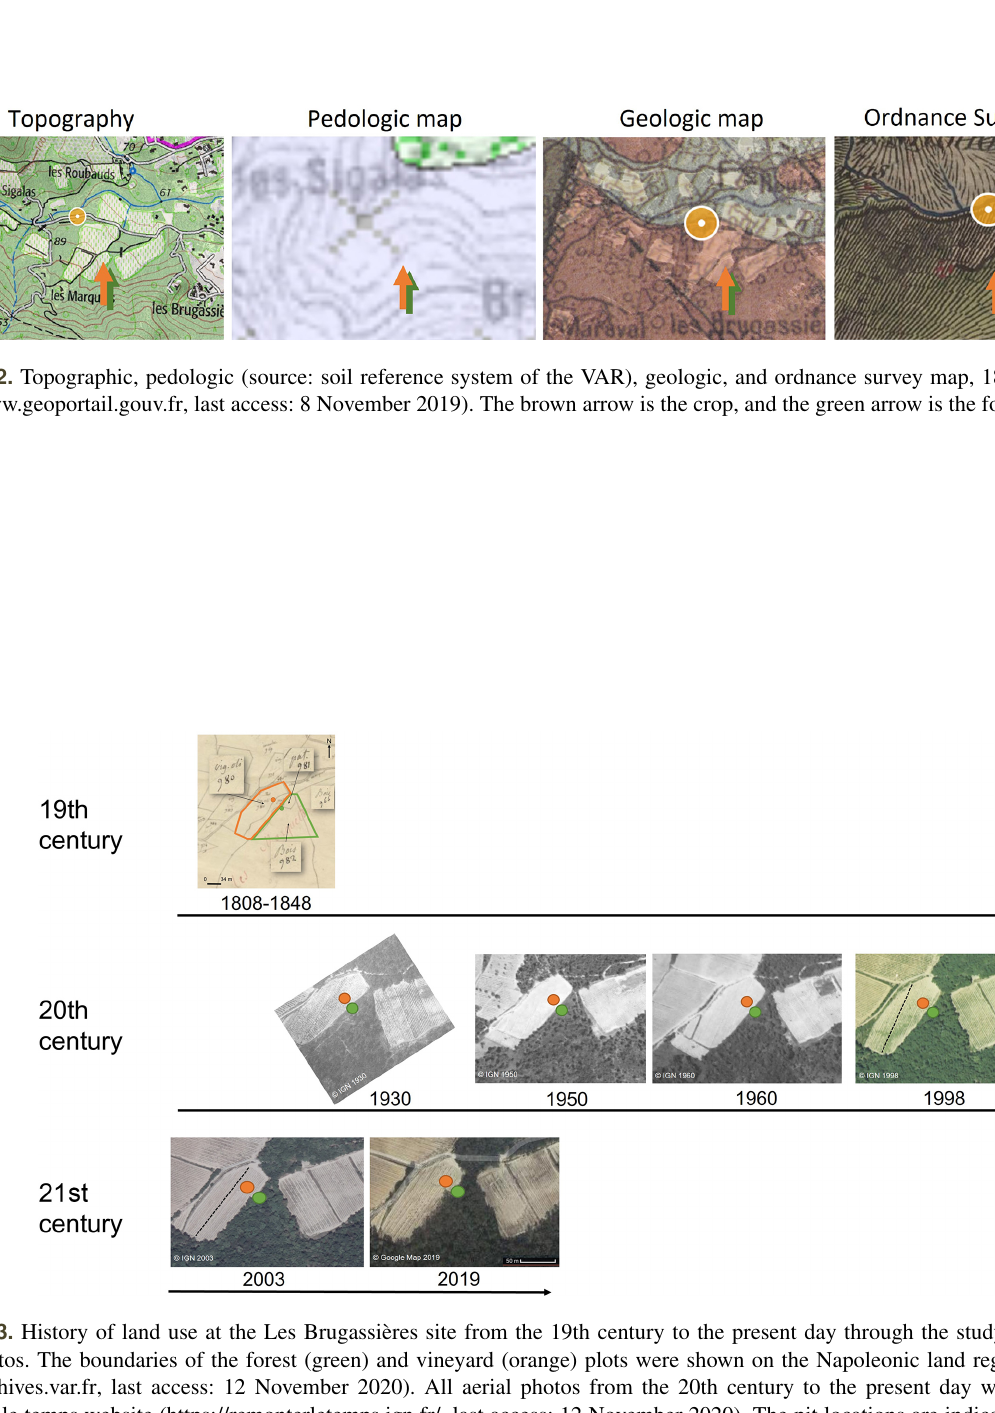
SOIL, 8, 517–539, 2022